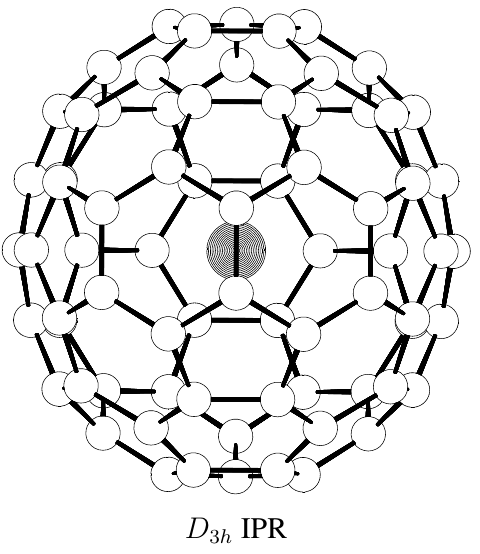
IPR-based isomer. 74